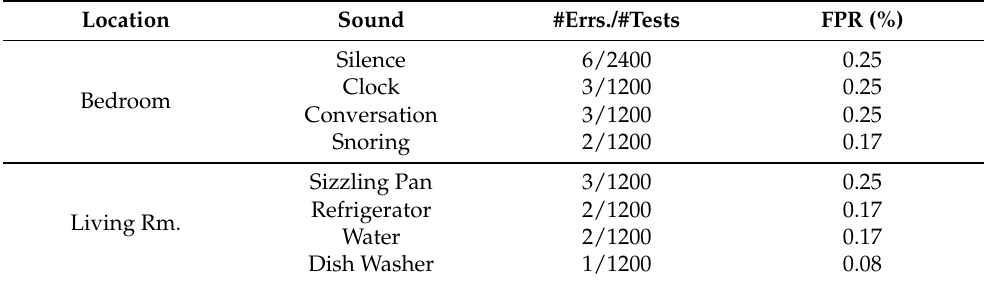
Table 6. False positive test